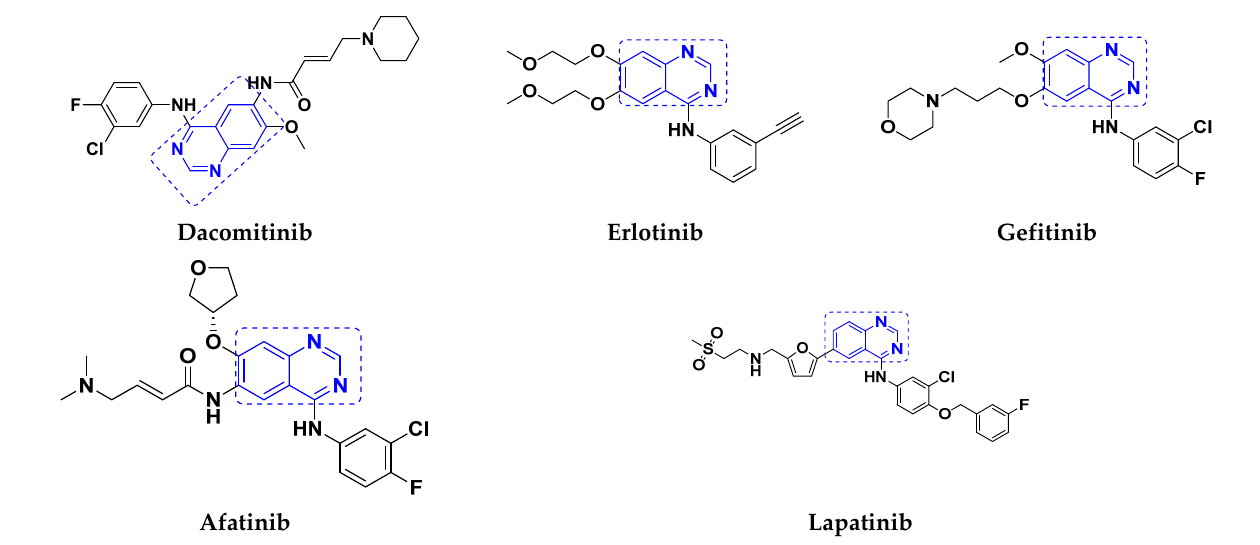
Figure 10. FDA approved/clinical trial drugs with quinazoline hybrids. Table 8. Quinazoline ‐ based compounds approved/under clinical trial with their current status.